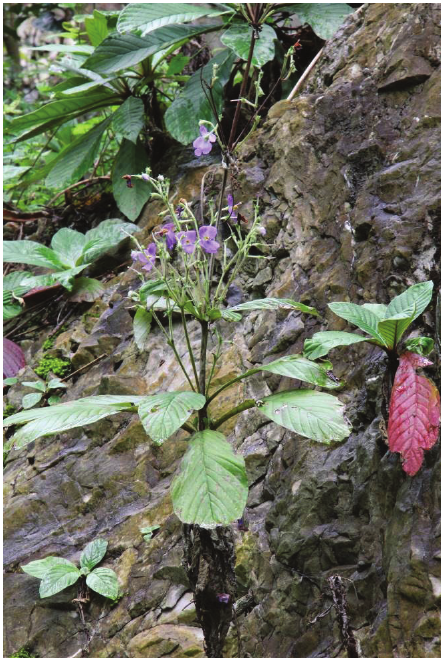
Figure 7. Paraboea verticillata (Gesneriaceae), one of a very few indigenous species that can colonise quarried rock